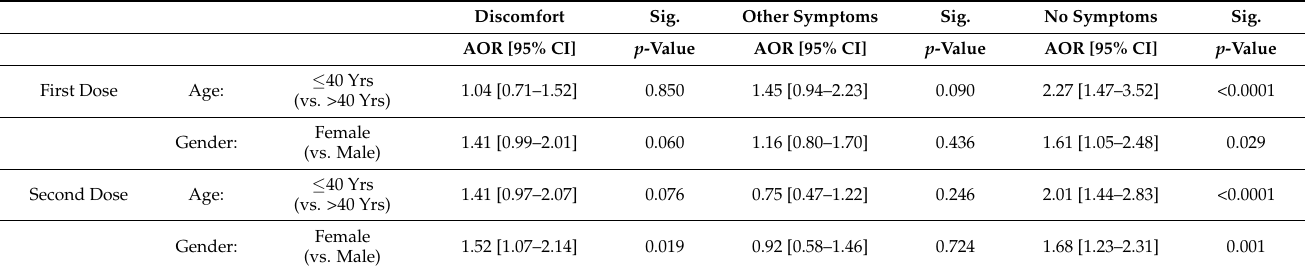
Table 6. Multiple logistic regression: effect of age and gender on discomfort at site, other symptoms, and no symptoms regarding side effects. Discomfort Sig. Other Symptoms Sig. No Symptoms